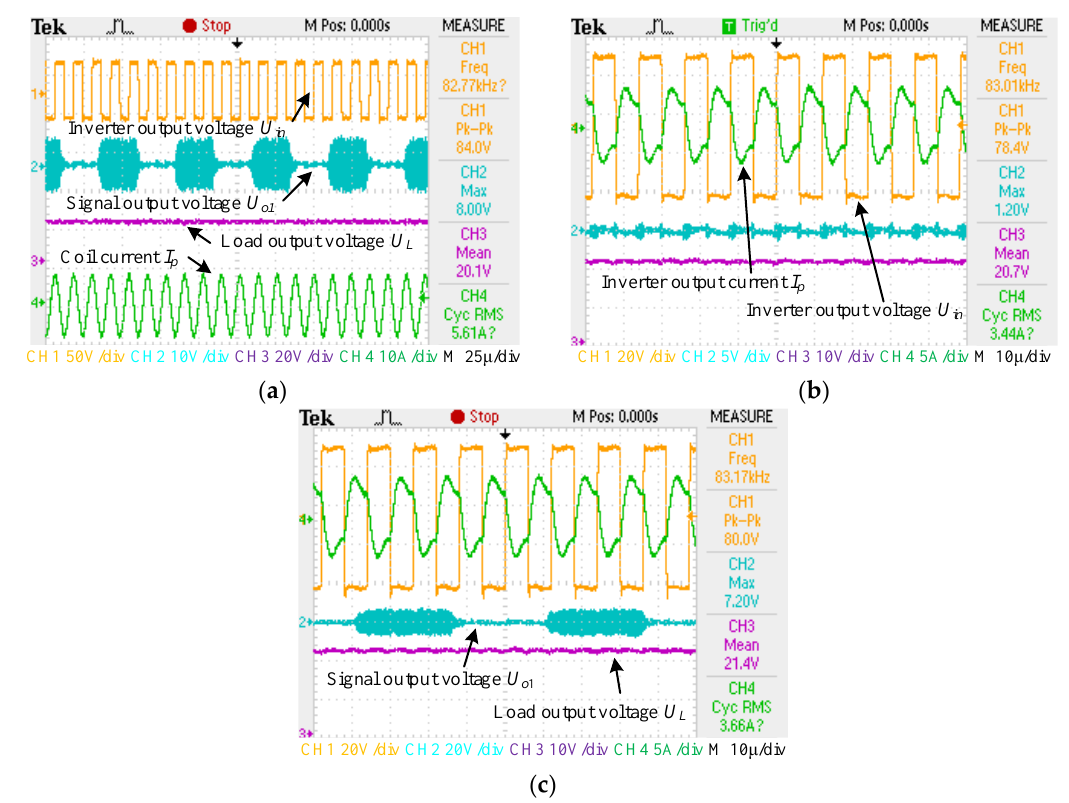
Figure 15. Waveforms of the power channel and data channel at optimal parameters ( a ) inverter output voltage, coil current, load output voltage and data output voltage; ( b ) SWPDT system without data transfer ( c ) SWPDT system with data transfer.